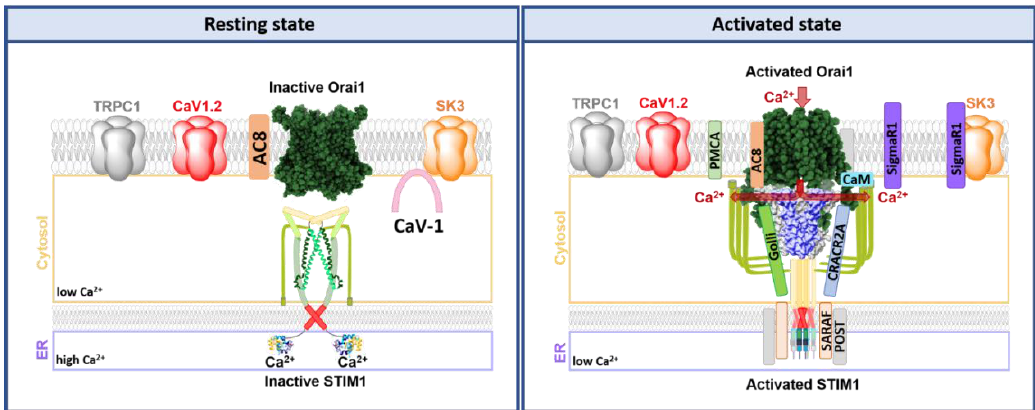
Figure 8. Resting and activated state of SOCE consisting of Ca 2+ related ion channels in close proximity to or in complex with diverse accessory proteins. Under resting conditions with high Ca 2+ concentrations in the ER, STIM1 and Orai1 remain in the quiescent state. In dependence of the cell type located in close proximity to TRPC1, CaV1.2, or interplay with adenylyl cyclase 8 (AC8) and/or SK3. Caveolin-1, proposed to interact with Orai1 as well as SK3 channel, is depicted in the inner face of the plasma membrane ( left panel ). Upon Ca 2+ store depletion, CRAC channel complex formation is modulated by accessory modulators such as Golli, CRACR2A, Calmodulin, SARAF, and POST ( right panel ). Interaction of adenylyl cyclase to activated Orai1 triggers downstream signaling processes such as cAMP-PKA pathway [363] (not shown). CRAC channel complexes can form within caveolae. There, STIM1 potentially interacts with and activates TRPC1. Interaction of SK3 channel with accessory modulator SigmaR1 is known to support SK3 and Orai1 co-localization to promote Orai1-dependent SK3 channel activation as outlined in Section 9.